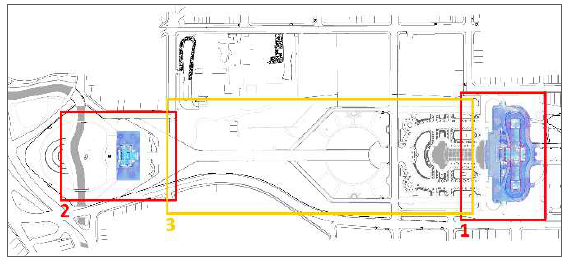
Figure 10. Museu do Ipiranga, Parque da Independência, Monumento à Independência do Brasil: 3D survey campaigns.